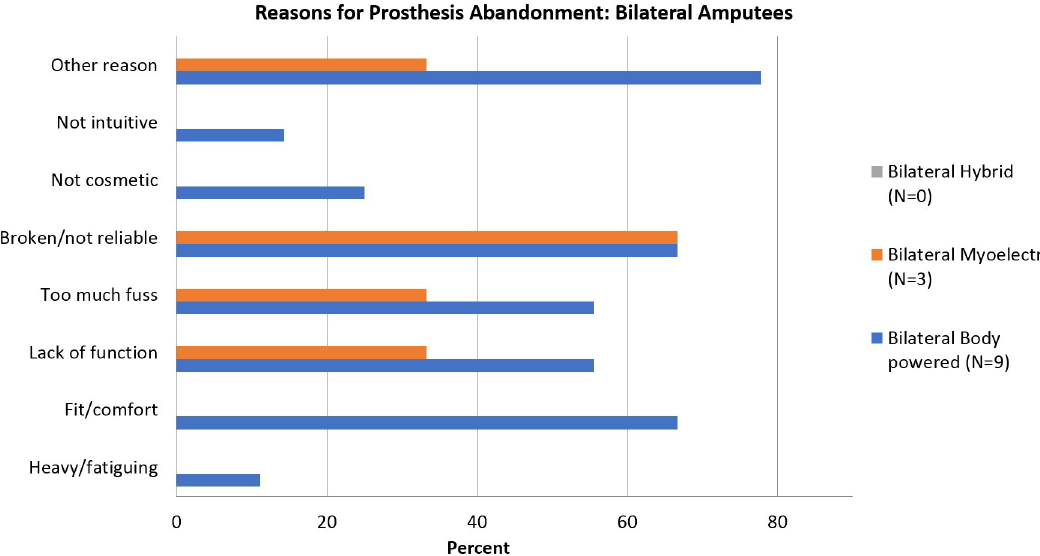
Fig 3. Reasons for prosthesis abandonment by type of device: Bilateral amputees.